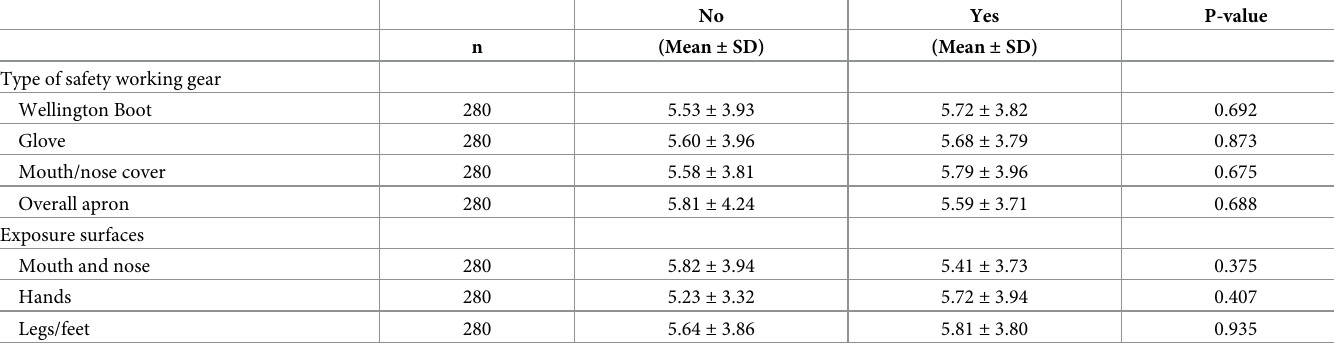
Table 3. Distribution of mean log concentrations of E . coli among waste handlers by use of personal safety working gears and exposure surfaces.